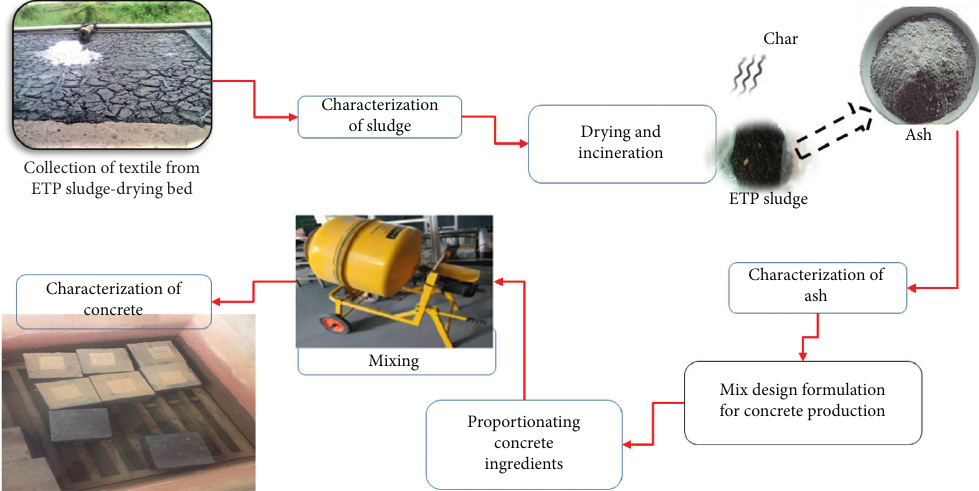
Figure 1: General work steps of the project. Table 1: Heavy metals on the sludge.